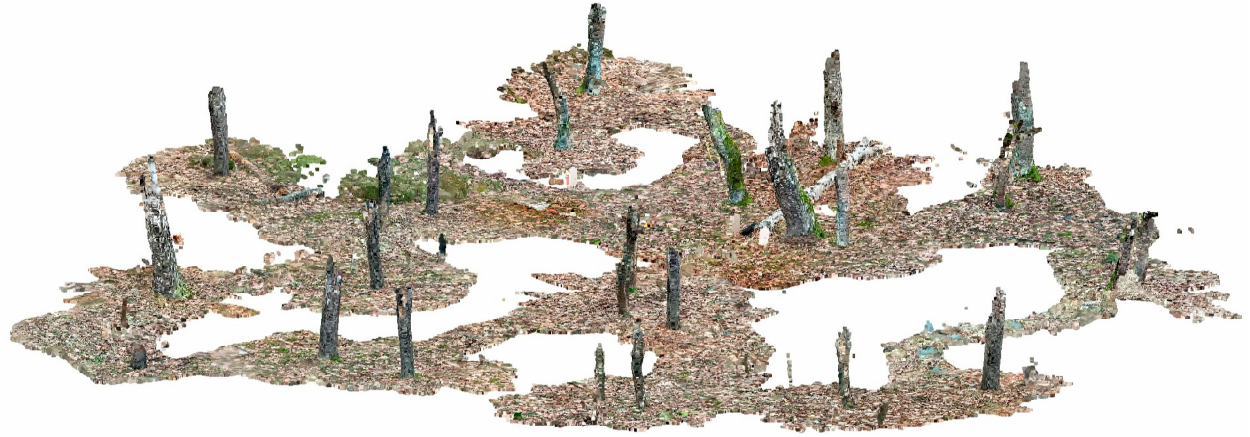
Figure 2. Visualization of point cloud LAS file captured by 3D Scanner App for one of the sample plots. Data are presented in the CloudCompare